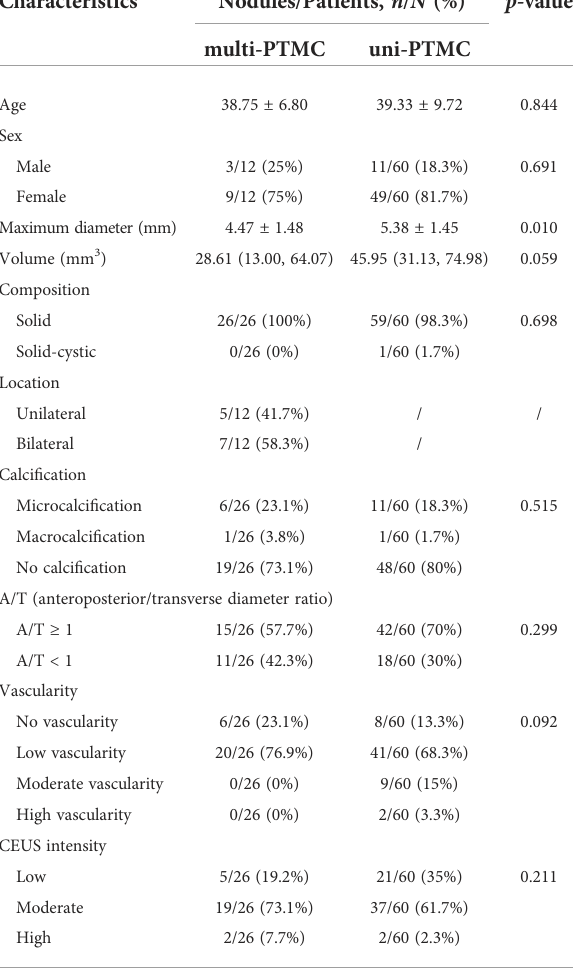
TABLE 1 Characteristics of patients and PTMCs between the two groups before PLA.